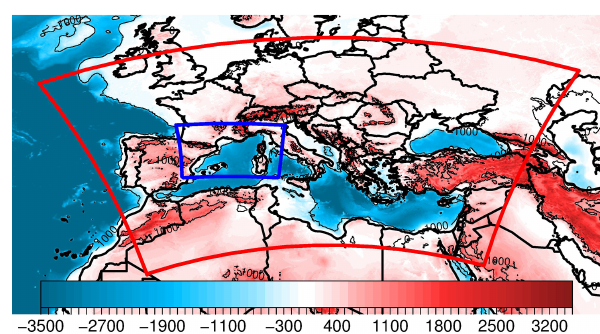
Figure 1. ETOPO1 (Amante and Eakins, 2009) orography and bathymetry data interpolated onto a 0.088 ◦ grid [m]. MedCORDEX domain in red, nested domain in blue.